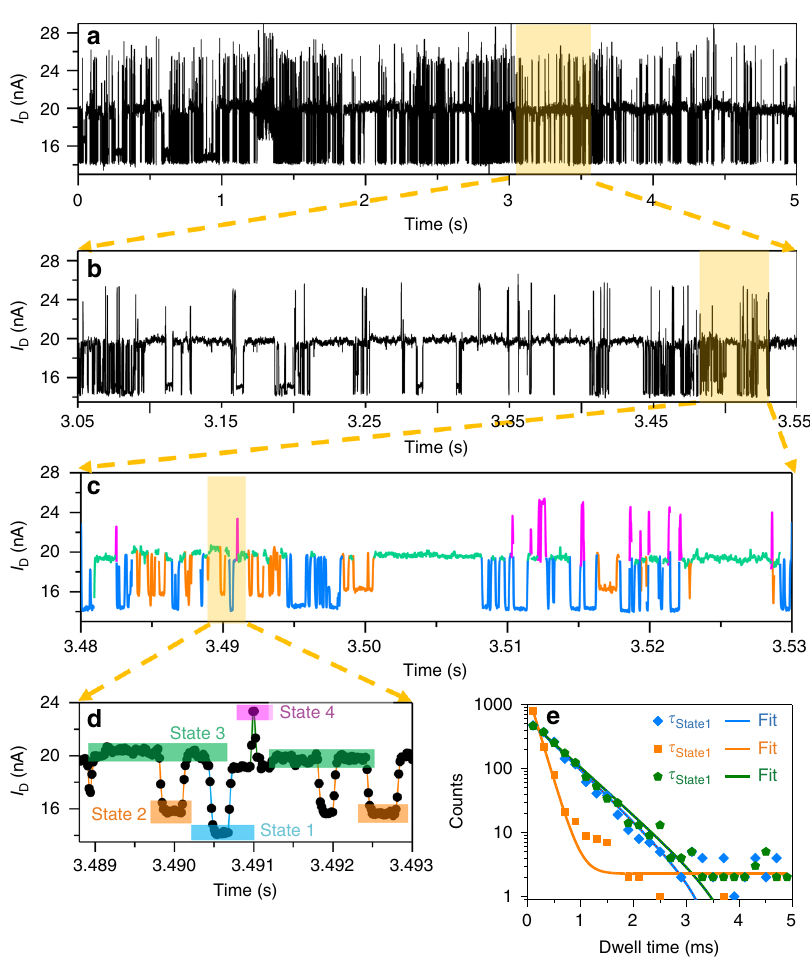
Fig. 4 Kinetic analyses of hydrogen bond dynamics in diphenyl ether. I – t curves of a HBB-SMJ device in diphenyl ether at 323 K at four different time scales ( a – d ) and the corresponding dwell-time histogram of States 1 – 3 in ( e ), showing a single-exponential decay fi tting with different lifetimes. V = 300 bias